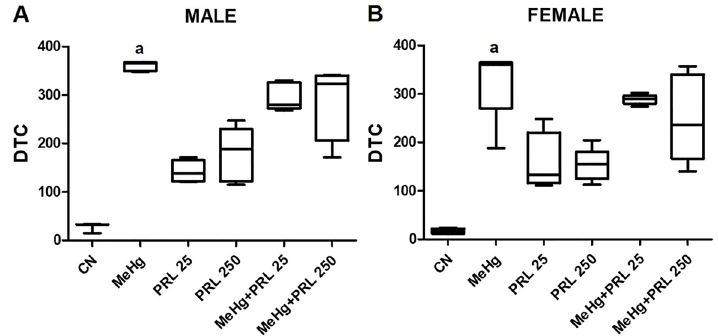
Figure 4. Degree of tissue change (DTC) in the kidney in each treatment group for ( A ) males and ( B ) females. Data are reported as medians and interquartile range. a P o 0.01 compared to the CN, PRL 25, and PRL 250 groups (ANOVA with Tukey ’ s post-test). CN: Control group; MeHg: methylmercury; PRL 25 and PRL 250: 25 and 250 m g/kg prolactin, respectively, every 12 h.